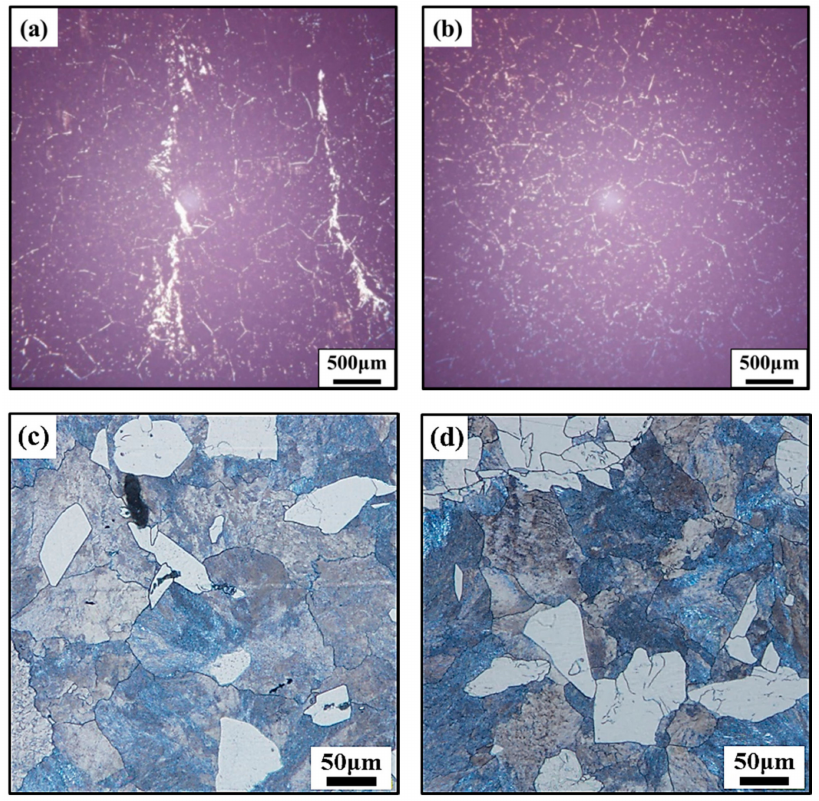
Figure 3. The SEM and OM images of 35CrMo steel ingot at 1/2R in Figure 1: ( a , c ) without ultrasonic, ( b , d ) with